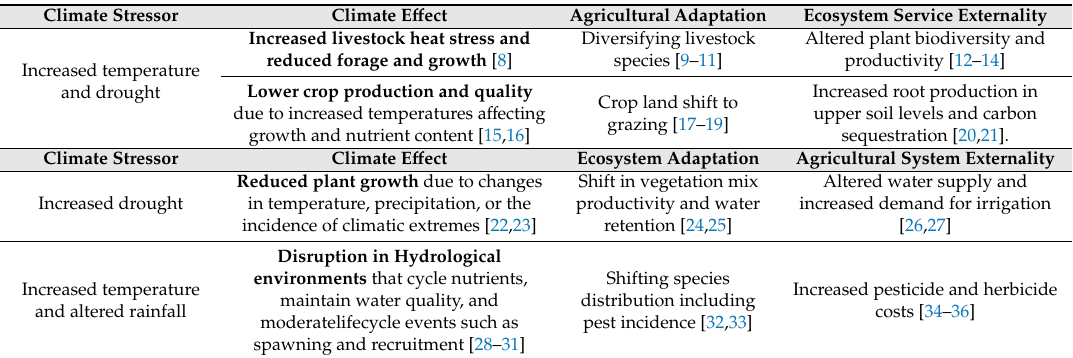
Table 1. Adaptations and externalities in response to climate stressors and e ff ects, adapted from